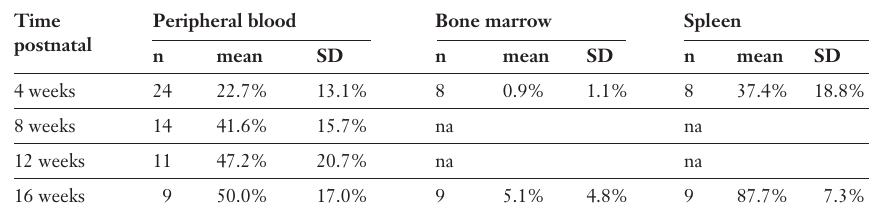
Figure 1 Prenatal kinetics of engraftment of donor cells from cord blood (circles) and fetal liver (triangles) found in fetal liver (figure 1A, above) and periph- eral blood (figure 1B, below) at different time points after in utero transplantation. The donor cell fre- quency is calculated as the percentage of human CD45 (in case of xenogeneic donor) or CD45.2 (in case of allogeneic donor) ex- pressing cells among the total of CD45.1 (mean,